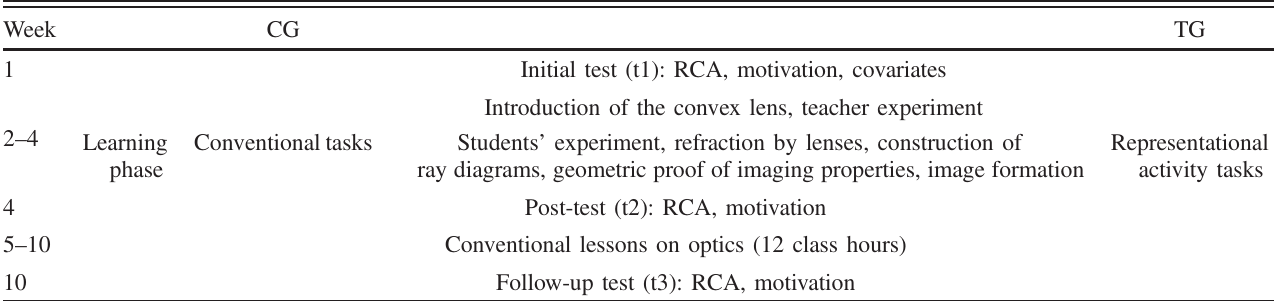
TABLE I. Schedule of the quasiexperimental intervention study [88].